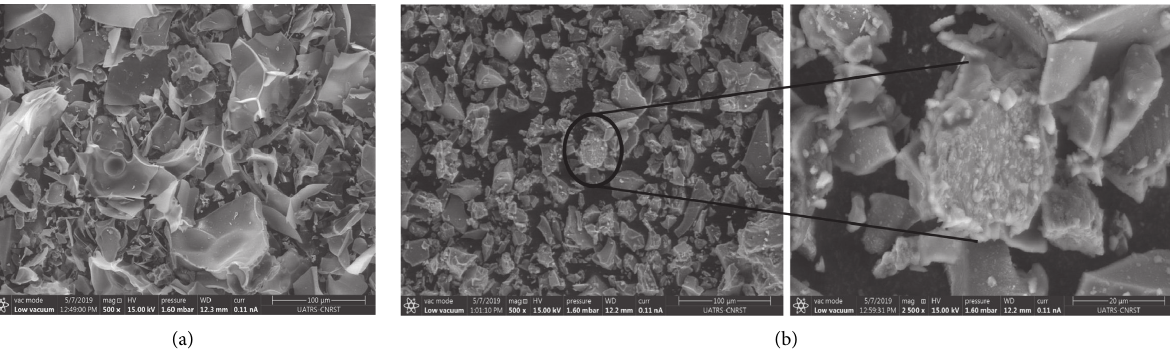
Figure 3: SEM images of (a) perlite and (b) geopolymer.